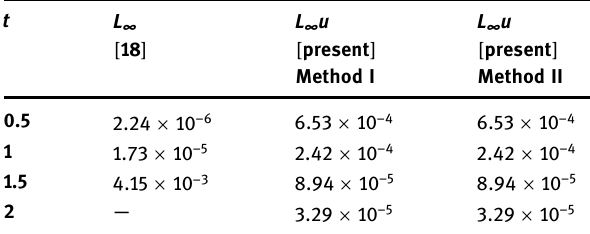
and L u are compared with [ 8 ] using ∞ Methods I and II. The present results are much better